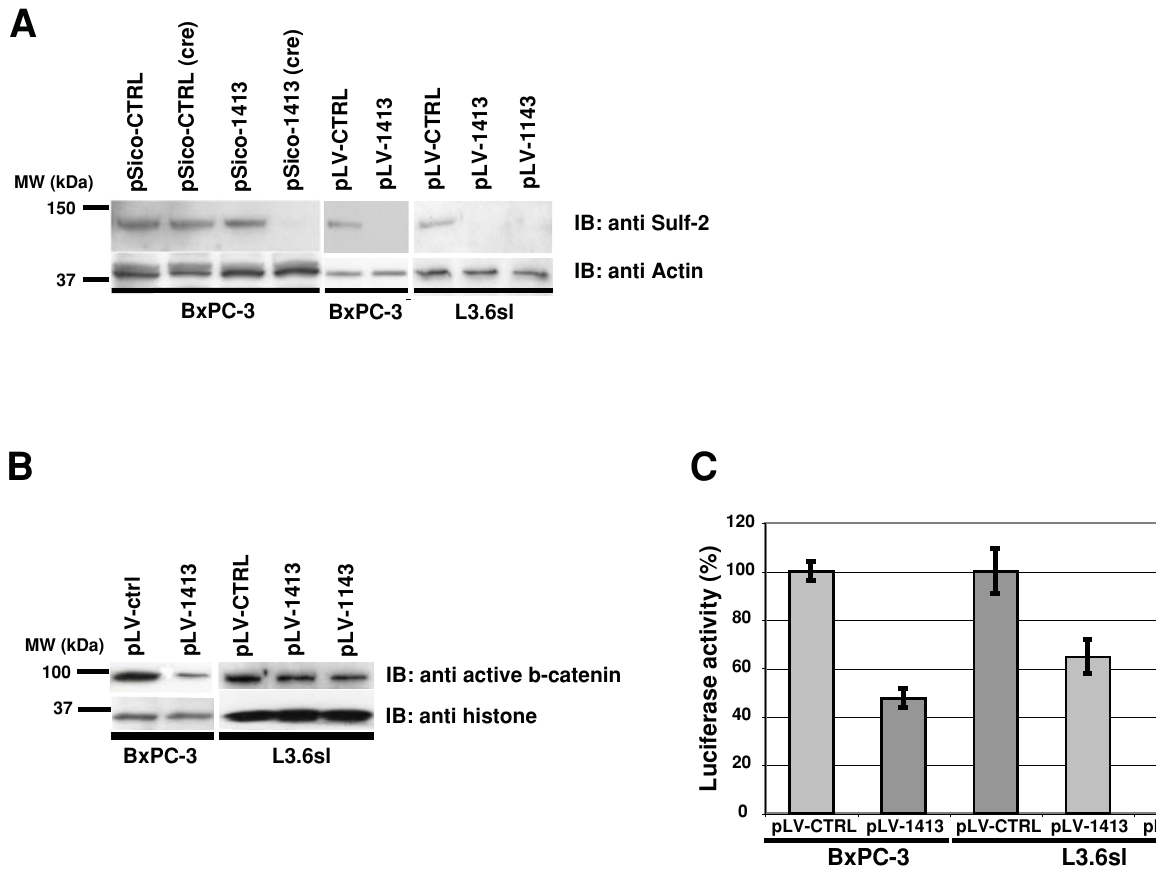
Figure 4. Wnt signaling in cells silenced for Sulf-2. A: Cells were transduced with the conditional (pSico) or nonconditional lentivirus (pLVTHM) encoding either Sulf-2 specific (1413, 1143) or control (ctrl) shRNAs. The cells were lysed and equal amounts of proteins were subjected to SDS-PAGE. In case of the pSico, cells were lysed 10 days after cre transfection. Sulf-2 protein levels were determined by performing immunoblots and the same lysates were probed with anti actin antibody as a loading control. B: 100 m g total protein of the nuclear fraction from the cells were applied to SDS- PAGE and amounts of active beta-catenin were detected using an antibody against non-phosphorylated beta-catenin. As loading control, the same lysates were analyzed with an anti histone antibody. C: Parental, pLV-ctrl, pLV-1413 and pLV-1143 transduced cells were transfected with the FOP/ TOPflash reporter system and luciferase activity was detected 48 hrs later. The values shown are the means 6 SD’s for 3 independent determinations and differences between ctrl and Sulf-2 silenced cells were statistically significant (BxPC-3, p=0.002 and (L3.6sl, p=0.013 and 0.017 for the two silencing vectors). (Figure 6B). The harvested tumors from silenced cells were correspondingly reduced in weight with no overlap of the two groups for either cell line (Figure 6C).